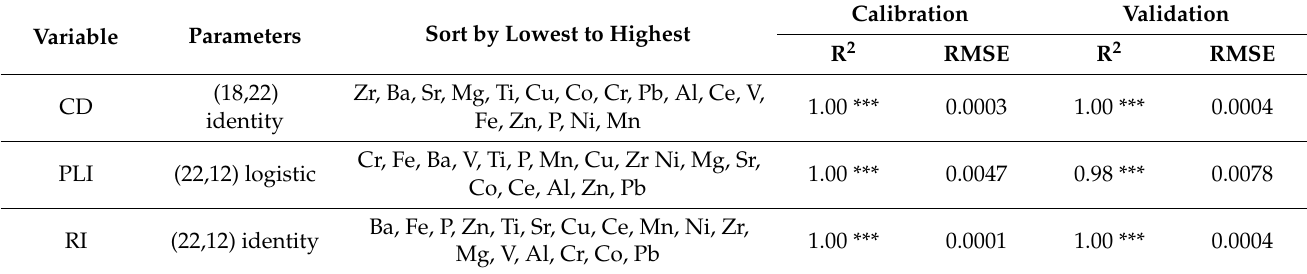
Table 12. Outcomes of calibration and validation models of ANN of the association between observed and predicted for potential ecological risk index (R1), contamination degree (CD), and pollution load index (PLI) in the two-year